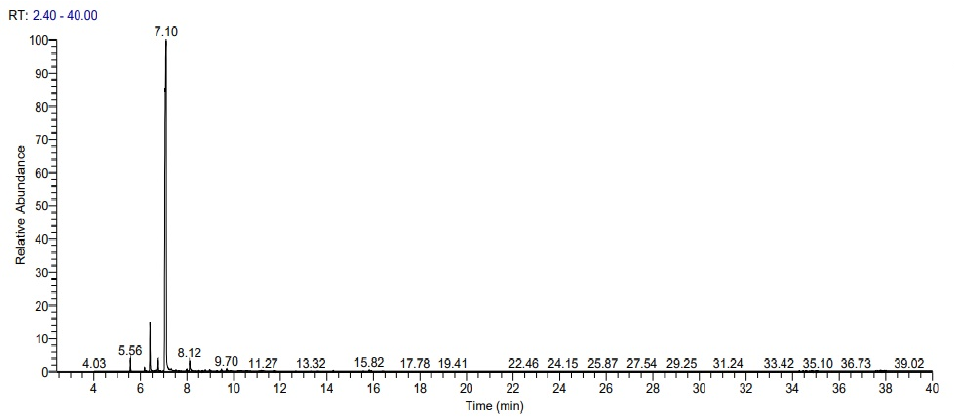
Figure 1. The total ion chromatogram of the peel of the C. limetta essential oil.